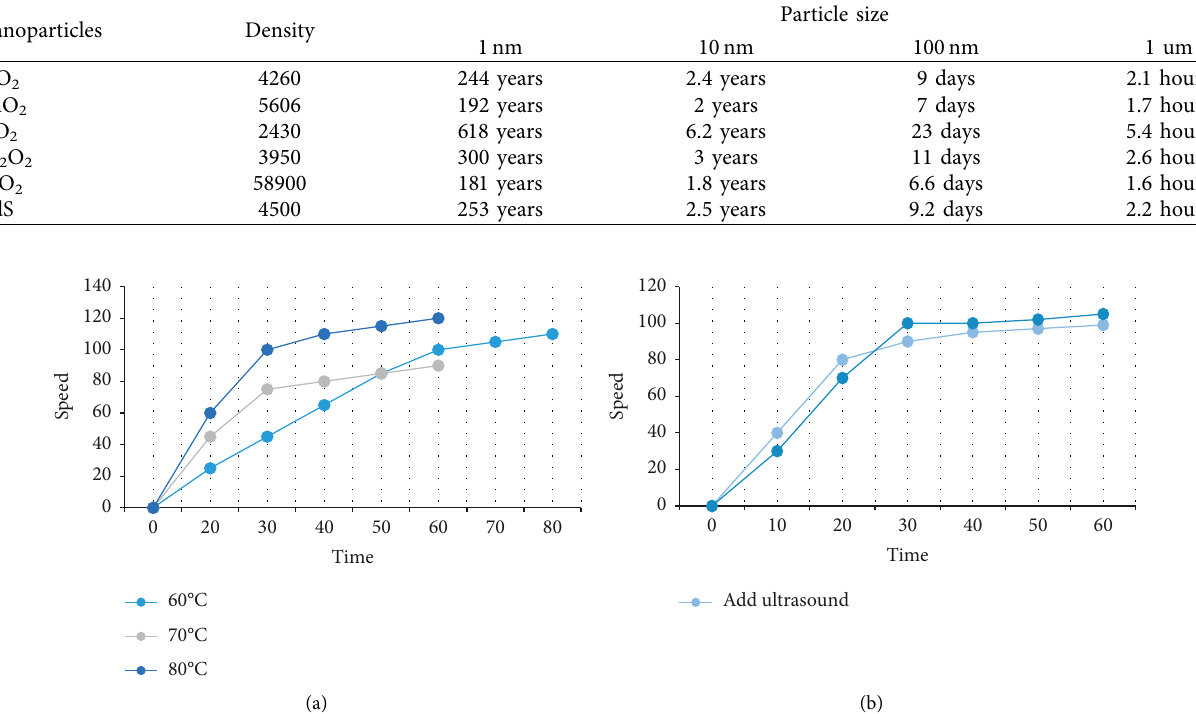
Table 3: Statistical table of time used to settle 10 mm in water.